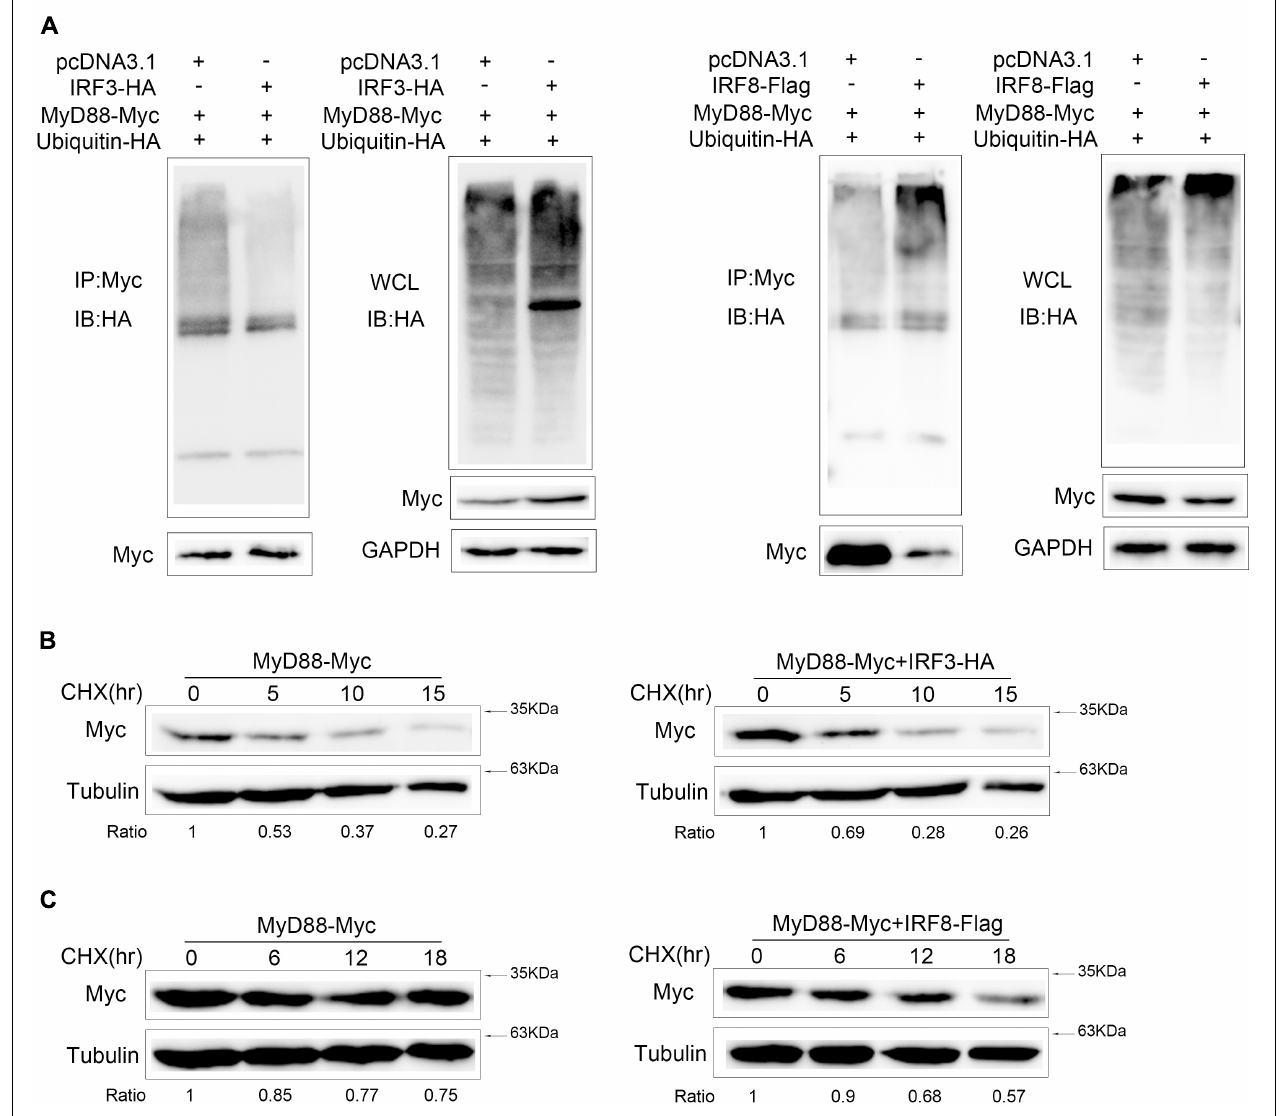
FIGURE 7 | IRF3 and IRF8 have the opposite effects on MyD88 polyubiquitination and its half-life. (A) HEK293 cells were seeded in 10-cm 2 dishes and cotransfected with 2 µ g of IRF3 or IRF8 and ubiquitin–HA plasmids together with 3 µ g of MyD88. At 24 h post transfection, the cells were treated with MG132 for 10 h. Then, the cells were lysed and IP analyses with Myc antibody and then WB with antibody against HA. Samples of whole-cell lysate (WCL) were included as controls. (B) Epithelioma papulosum cyprini (EPC) cells were transiently cotransfected with 0.4 µ g of MyD88 and IRF3 plasmids for 24 h, and then the cells were treated with CHX (100 µ g/ml) and harvested at different time points. MyD88 was determined by immunoblot assays. (C) EPC cells were cotransfected with 0.4 µ g of MyD88 and IRF8 plasmids for 24 h, and the cells were treated with CHX (100 µ g/ml) and harvested at different time points. MyD88 was determined by immunoblot assays. All experiments were performed in at least three independent